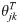
Coancestry matrices of simulations.Both panels have n = 1000 individuals along both axes, K = 10 subpopulations (final or intermediate), and FST = 0.1. Color corresponds to θjkT between individuals j and k (equal to φjkT off-diagonal, fjT along the diagonal). (A) The independent subpopulations model has θjkT=0 between subpopulations, and varying θjjT per subpopulation, resulting in a block-diagonal coancestry matrix. (B) Our admixture scenario models a 1D geography with extensive admixture and intermediate subpopulation differentiation that increases with distance, resulting in a smooth coancestry matrix with no independent subpopulations (no θjkT=0 between blocks). Individuals are ordered along each axis by geographical position.